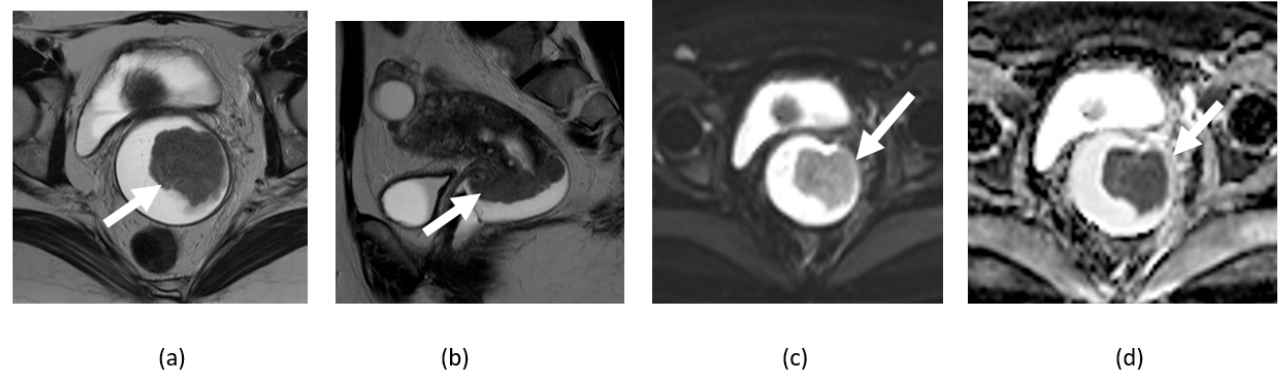
Figure 13. Axial ( a ) and sagittal ( b ) T2-weighted images with vaginal gel shows a large exophytic cervical mass (arrows) from cervical cancer with diffusion restriction on corresponding diffusion weighted image ( c ) and ADC map ( d ).